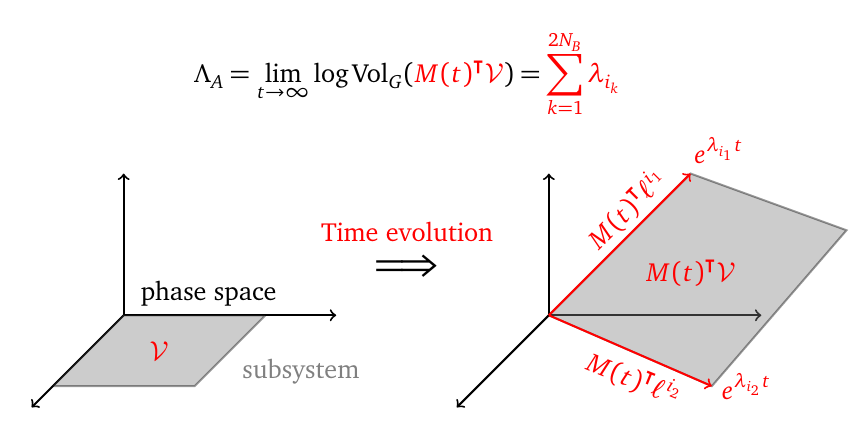
Figure 3: Subsystem exponent due to phase space stretching. The subsystem expo- nent (27) describes the exponential volume growth of an initial parallelepiped V whose span is equal to V ∗ under the symplectic time evolution M ( t ) B based on the respective figure in [ 18 ]